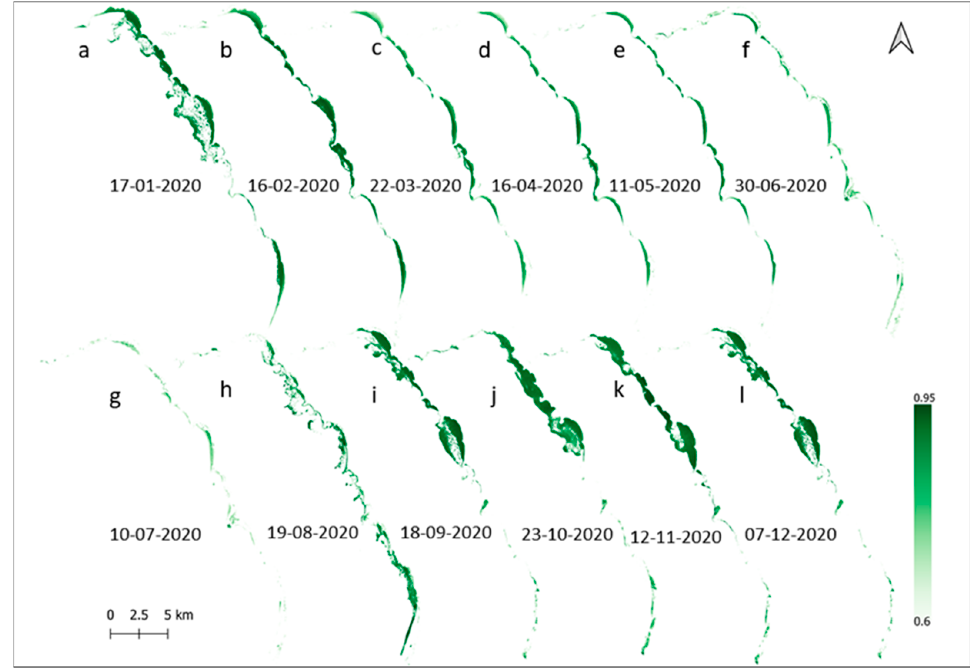
Figure 7. ( a )–( l ) Water hyacinth expansion in cover and biomass for each month fro January 2020 to December 2020 during the study year in 2020 extracted from Sentinel ‐ 2 Level ‐ 2 satellite images (Sen2Cor) using the NDVI.